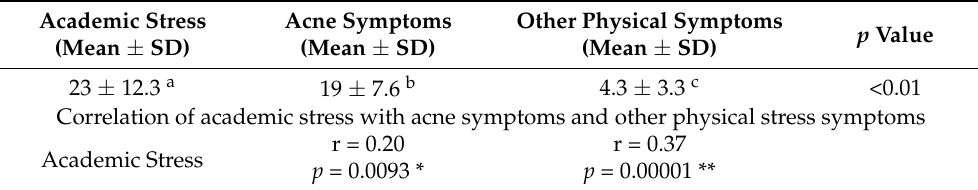
Table 3. Comparison and correlation of overall academic stress with acne symptoms and other physical symptoms. Academic Stress